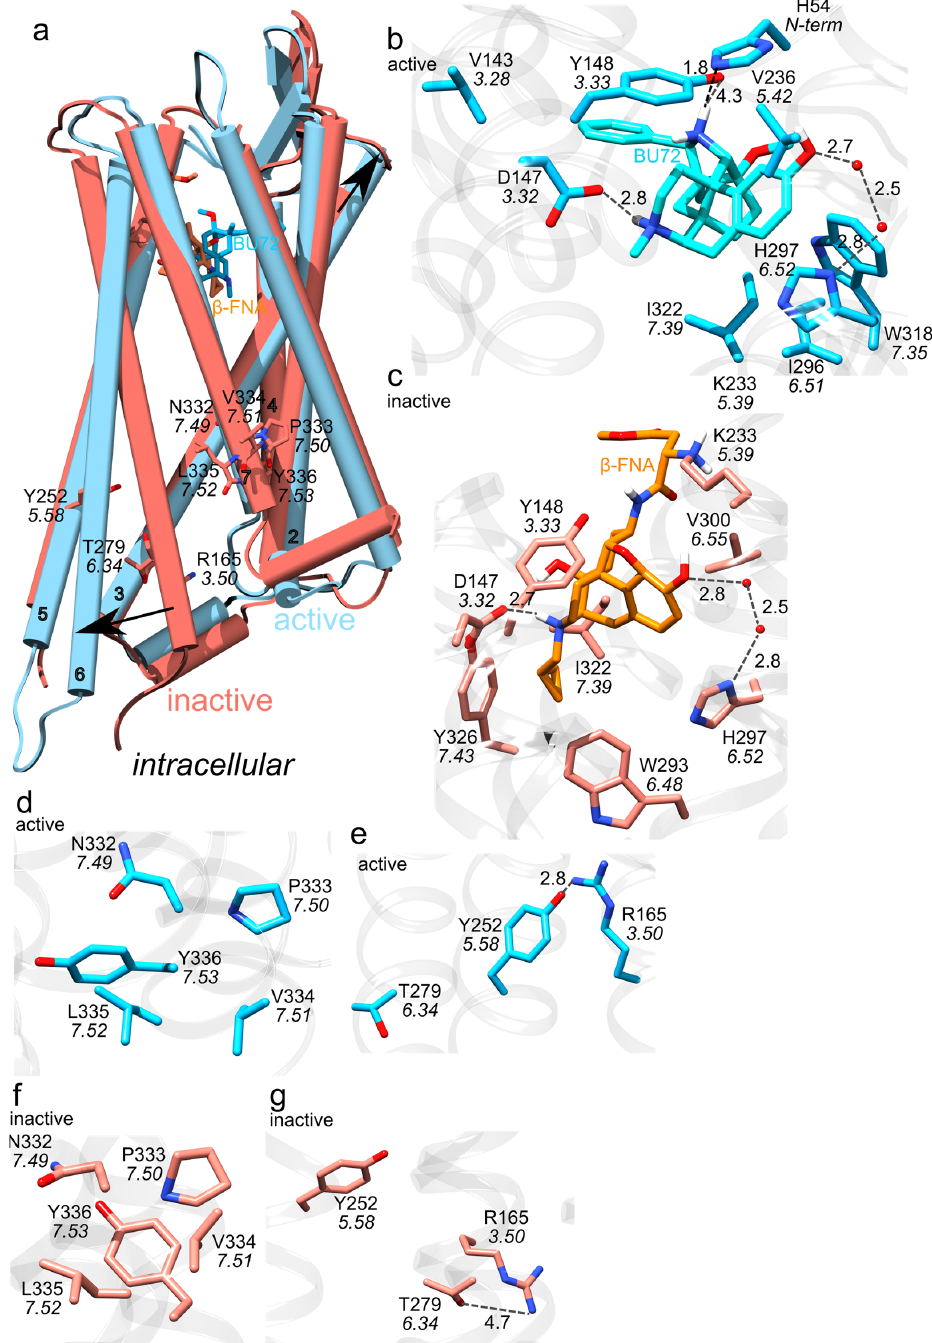
Figure 3. Active vs. inactive MOR. ( a ) Overlap of the structures of active-MOR (blue) and inactive- MOR (red); three-dimensional structures are from PDB ID:5C1M [32] and PDB ID:4DKL [33], respectively. The black arrows indicate that TM3 and TM6 have distinct orientations in the two protein structures. ( b , c ) Close view of binding site interactions in structures bound to the agonist BU72, vs. the antagonist β -FNA. Blue carbon bonds represent interactions in the active receptor, and orange, in the inactive receptor. Grey dotted lines represent H-bond interactions. ( d , f ) Close view of the NPxxY motif in active (blue bonds) vs. inactive MOR (orange bonds). ( e , g ) Close view of the ionic lock. R3.50 interacts with T6.34 in inactive MOR (orange bonds), vs. with T5.58 in active MOR (blue bonds). Molecular graphics were prepared using UCSF Chimera 1.14 [23] and the text was added with Inkscape 1.0.